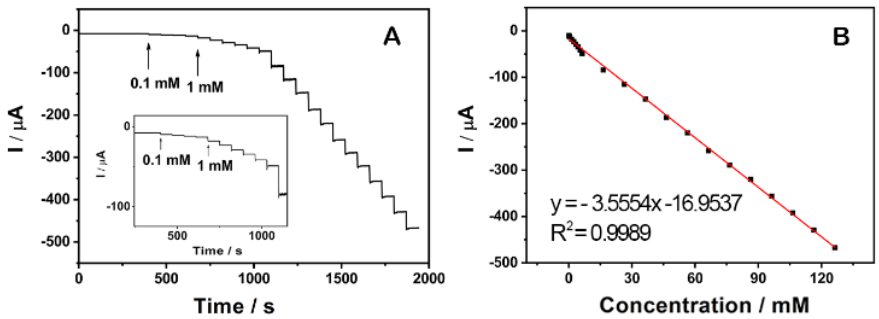
Figure 9. Typical steady-state response of the rGO / PANI@PtNi GCE to successive injection of H 2 O 2 into the N 2 -saturated 0.2 M PBS with pH = 6.5 at 0 V. Inset: the amplified response curve at low concentrations ( A ); the corresponding calibration curve at 0 V ( B ). Table 2. Comparison of the electrochemical performance of H 2 O 2 sensors based on the graphene composites.